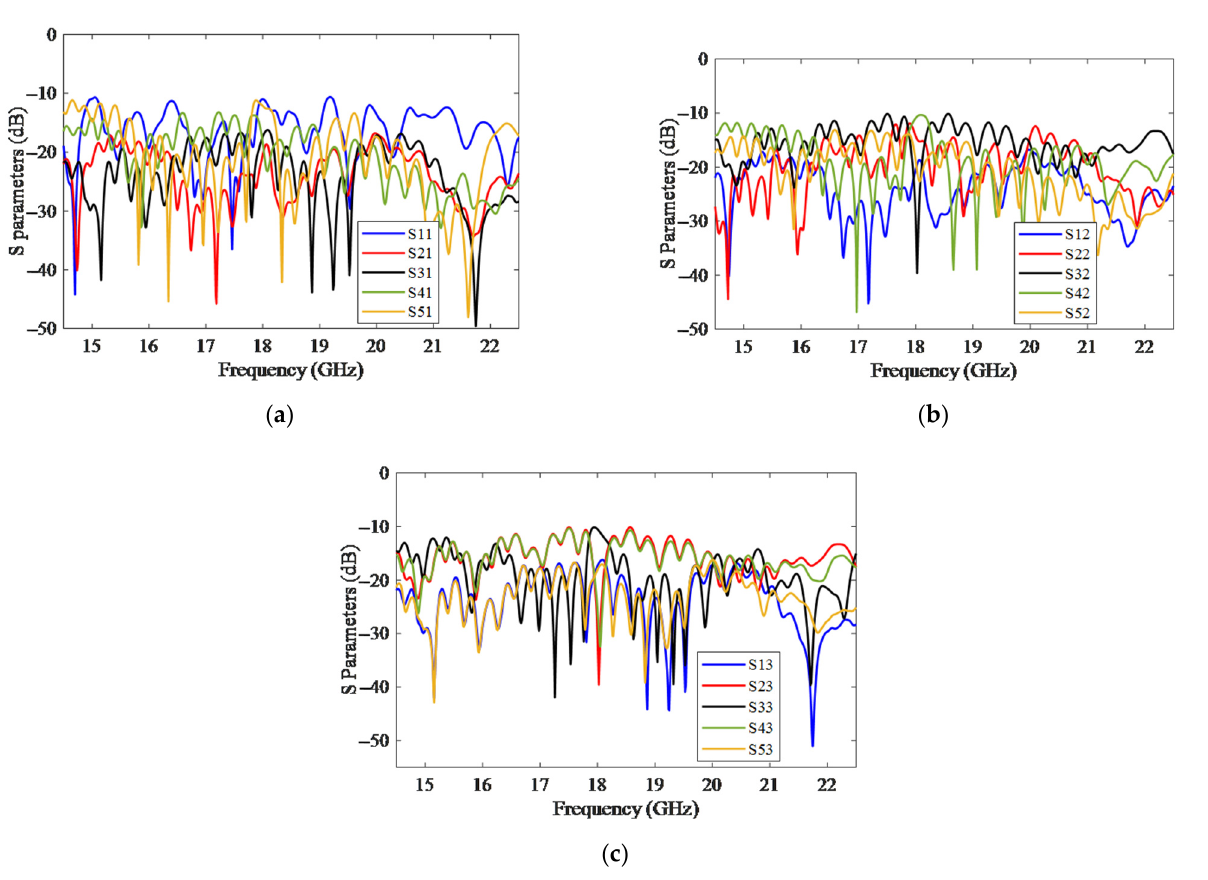
Figure 8. The S parameters of the 2D-MBA for the excitation of different beam ports: ( a ) port 1, ( b ) port 2, and ( c ) port 3.